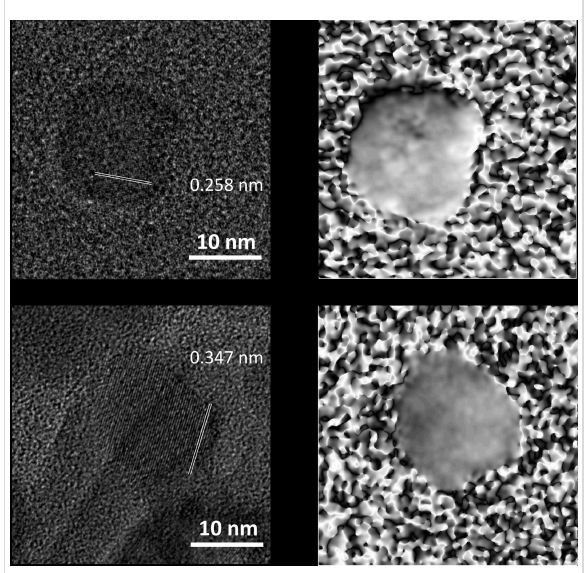
Figure 2: HRTEM images (left) and geometric phase analysis (GPA, right) of α -MnS and γ -MnS NCs. (a) α -MnS NCs prepared from Mn 2 (CO) 10 in the presence of StAc (S/StAc/Mn = 2:4:1, where St = stearic acid) displaying 0.258 nm lattice fringes corresponding to {200} planes. (b) γ -MnS NC prepared from MnSt 2 in the presence of HdAm (S/HdAm/Mn = 2:4:1, where HdAm = hexadecylamine) displaying 0.347 nm lattice fringes corresponding to {100} planes.